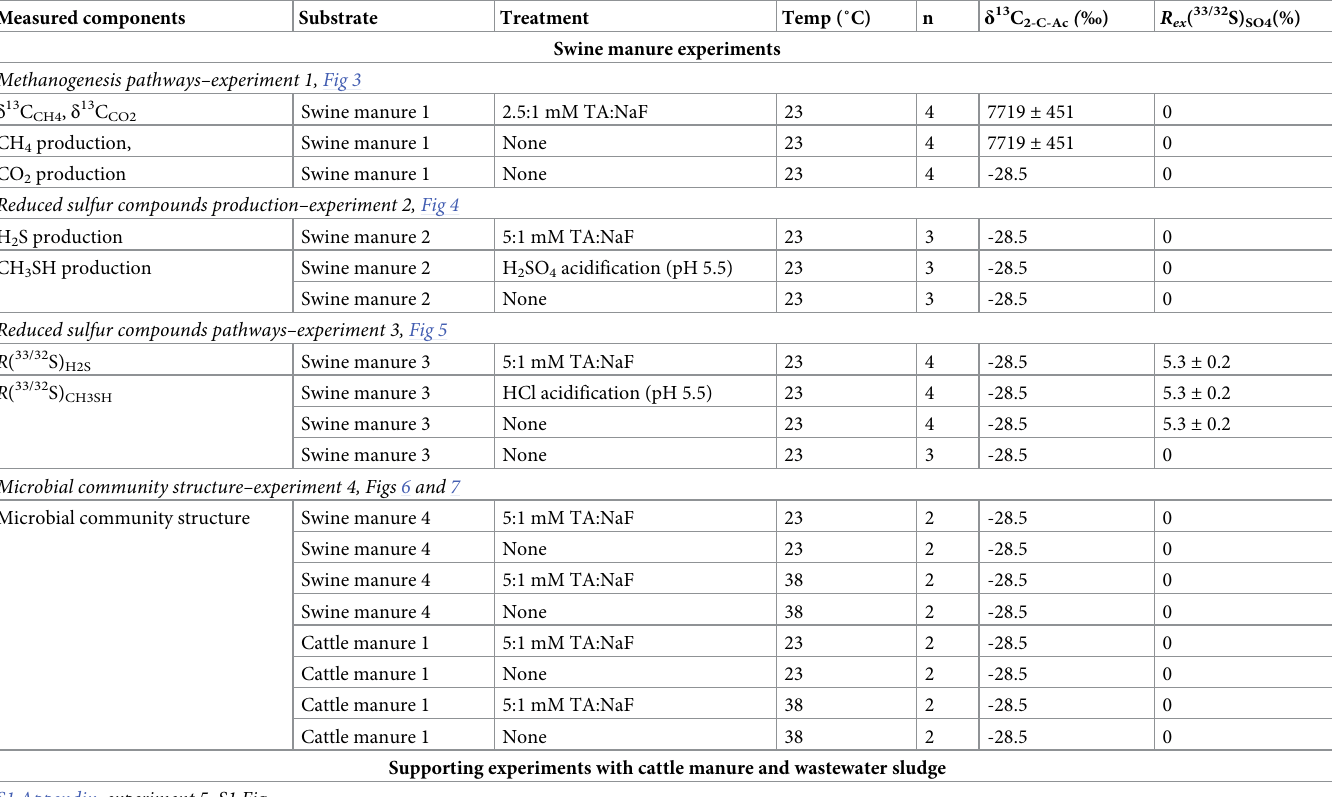
Table 1. Detailed experiment